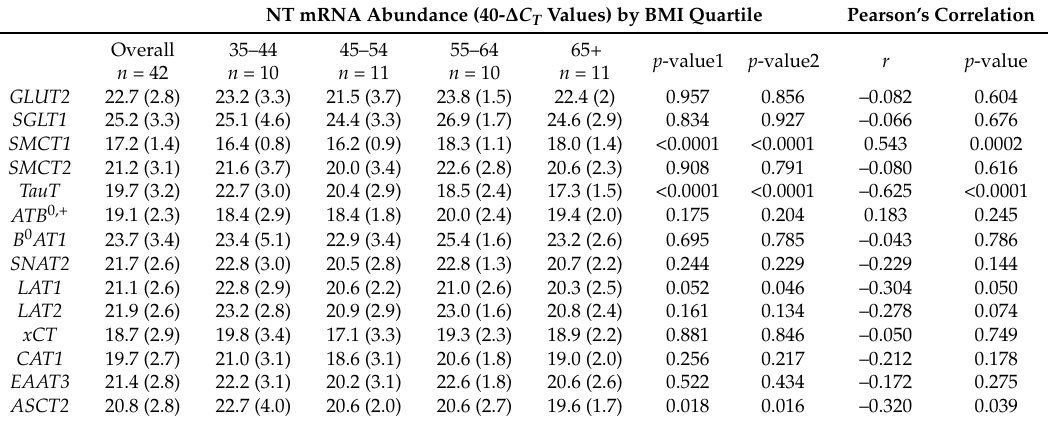
Data presented as mean (standard deviation); p ‐ value1 = linear trend without adjustment; p ‐ value2 =